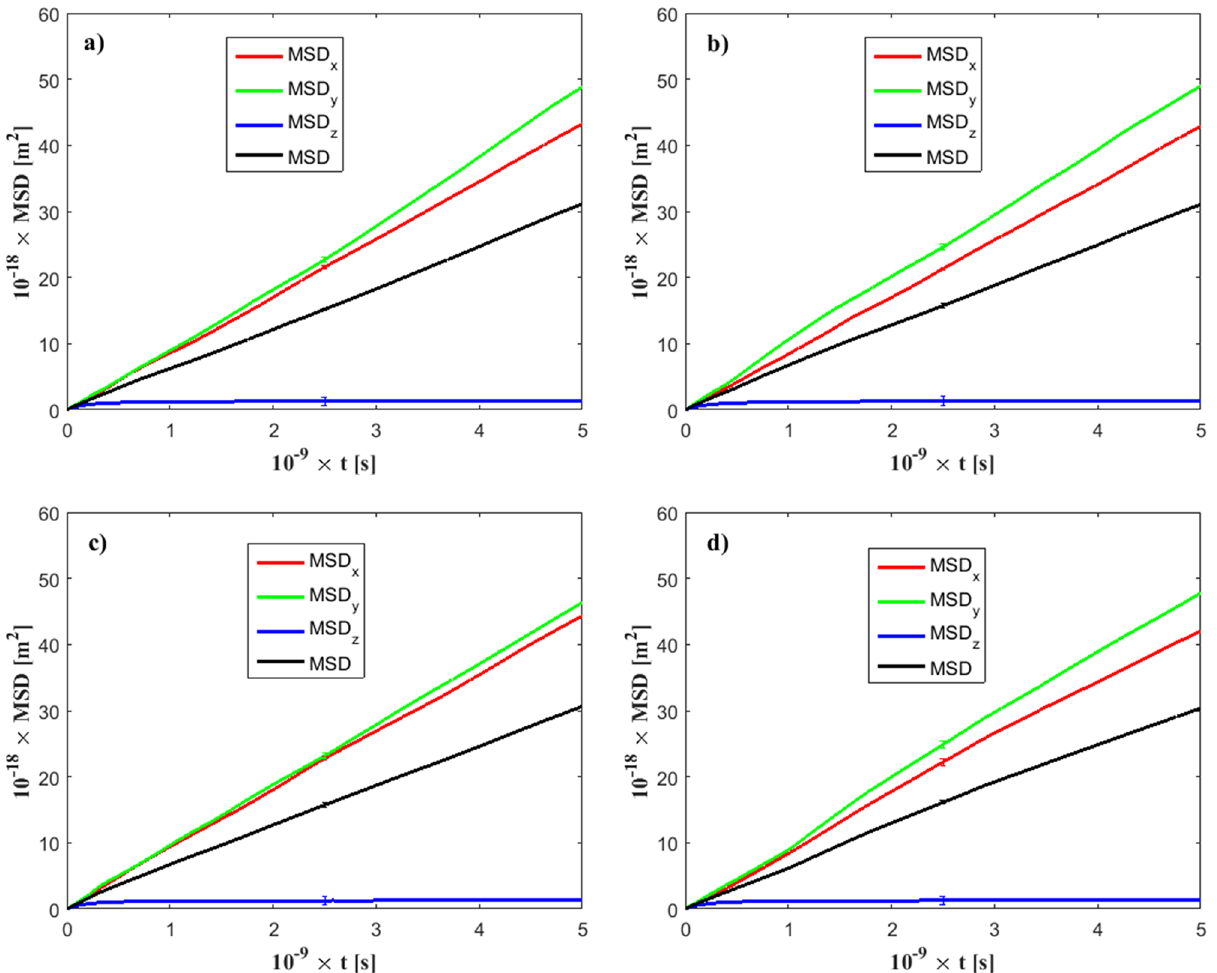
Figure 4. Calculated mean square displacement of fluid particles. Standard deviation is displayed in the middle of each line. h = 3 nm, ε wf /ε ff = 0.1 . ( a ) E z = 0.0 V/nm and no ions are present in the solution (pure water), ( b ) E z = 1.0 V/nm and no ions are present in the solution, ( c ) E z = 0.01 V/nm, for ion concentration c = 0.58 M, ( d ) E z = 0.1 V/nm, for ion concentration c = 0.58